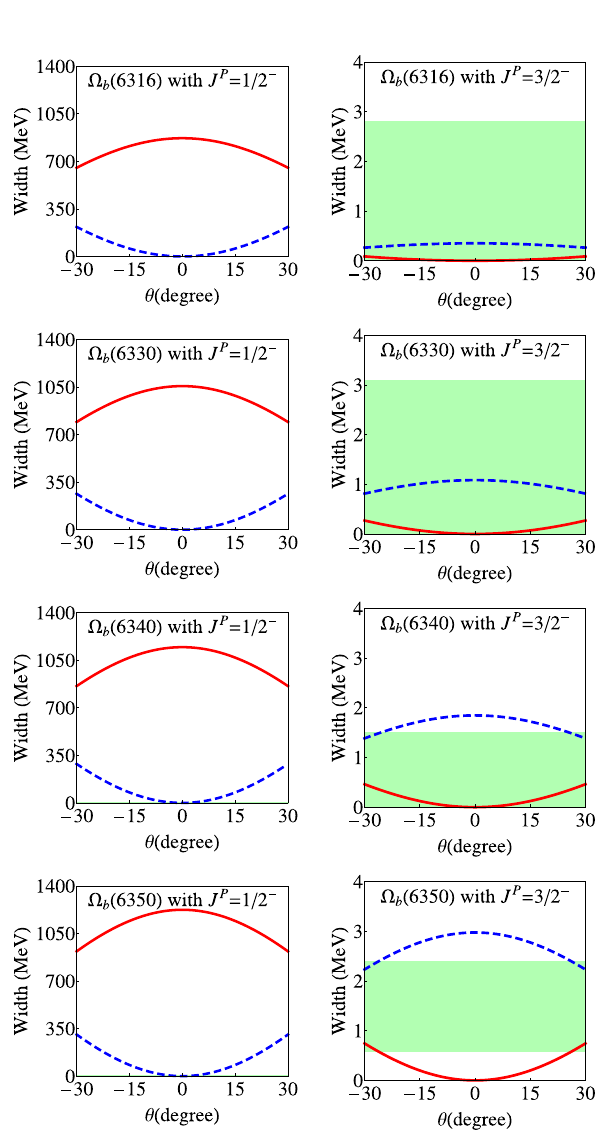
Fig. 3 The total decay widths of various assignments as functions of the mixing angle θ in the range − 30 ◦ ∼ 30 ◦ . The red solid lines are the | 1 P 1 / 2 − (cid:7) 1 and | 1 P 3 / 2 − (cid:7) 1 states, and the blue dashed curves correspond to the | 1 P 1 / 2 − (cid:7) 2 and | 1 P 3 / 2 − (cid:7) 2 states. The green bands stand for the measured total decay widths with errors This explains why the LHCb experiment only observed four K − mass spectrum. Our present results are peaks in the (cid:3) 0 b consistent with the previous chiral quark model